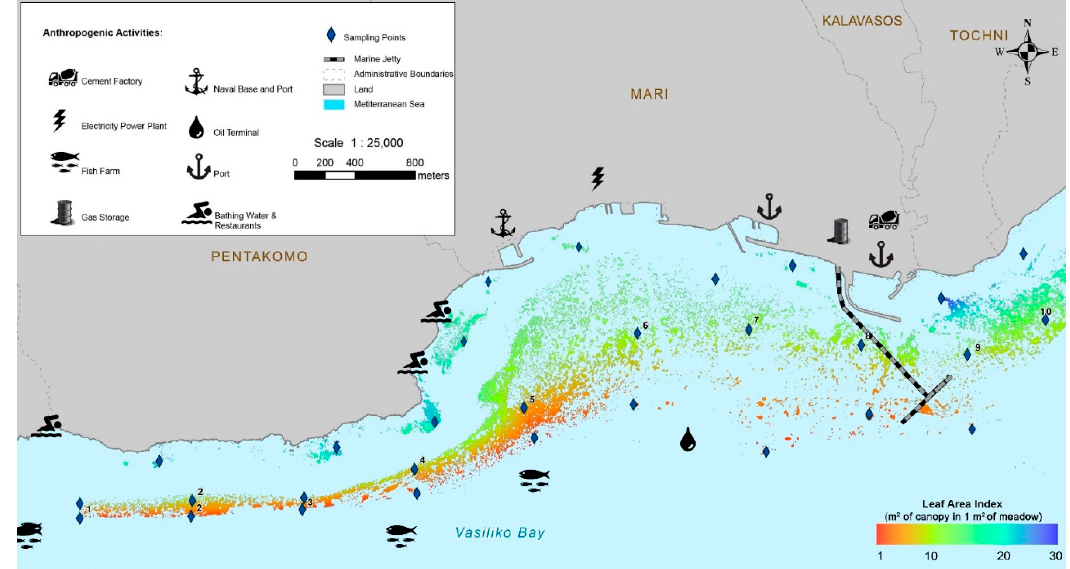
Figure 5. Posidonia oceanica leaf area index (LAI) (m 2 of seagrass canopy in 1 m 2 of seagrass bottom) heat map, interpolated using the algorithm of the ‘Nearest Neighbour’, and the mean LAI values of all sampling stations.